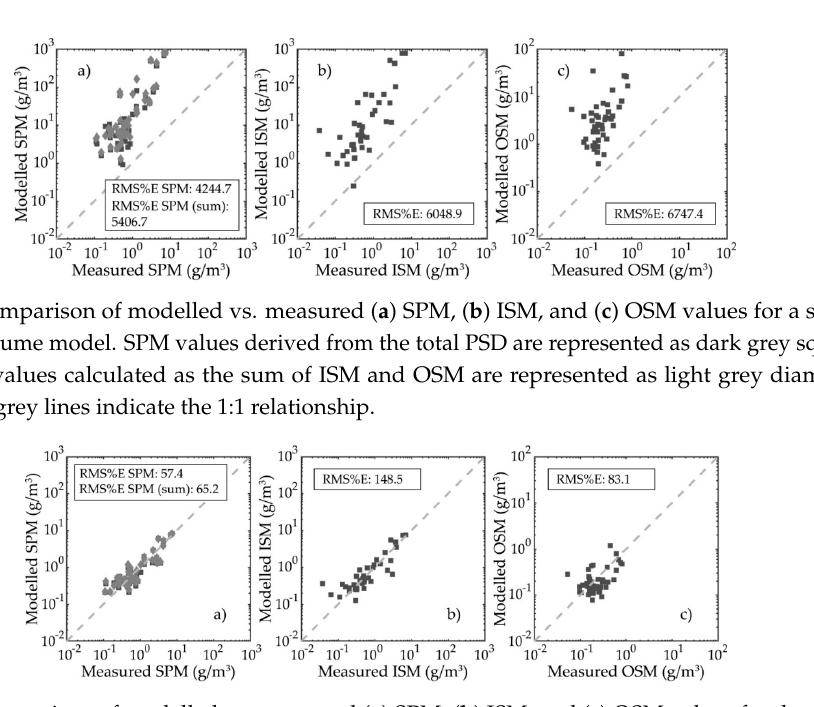
Figure 5. Comparison of modelled vs. measured ( a ) SPM, ( b ) ISM, and ( c ) OSM values for the fractal volume model. SPM values derived from the total PSD are represented as dark grey squares, while SPM values calculated as the sum of ISM and OSM are represented as light grey diamonds. The dashed grey lines indicate the 1:1 relationship.